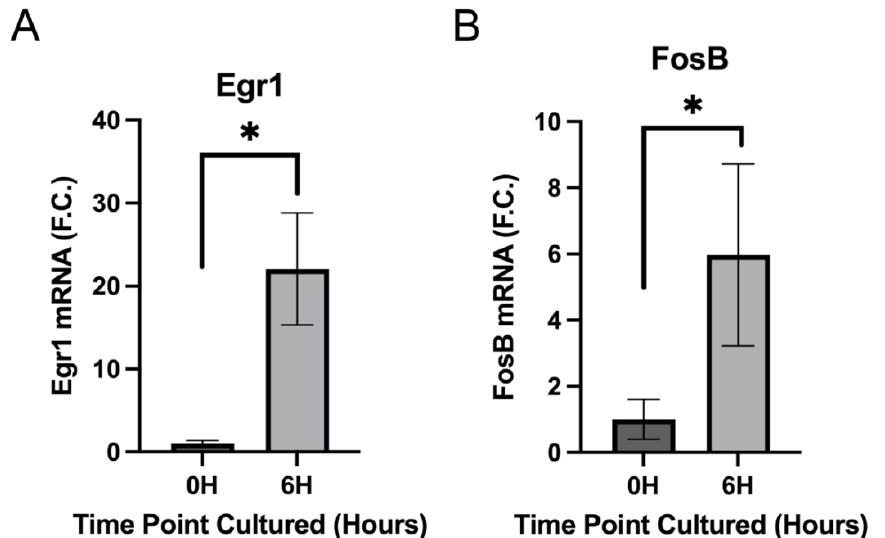
Figure 5. Investigation of the effect of 6 h ex vivo culture on Egr1 and FosB levels in LECs by qRT-PCR ( A ) Egr1 mRNA levels significantly upregulate in LECs after six hours of ex vivo culture (* p -value ≤ 0.01) ( B ) FosB mRNA levels signficantly upregulate in LECs after six hours of ex vivo culture (* p -value ≤ 0.025) FC-fold change from RNA levels obtained from LECs immediately after isolation.